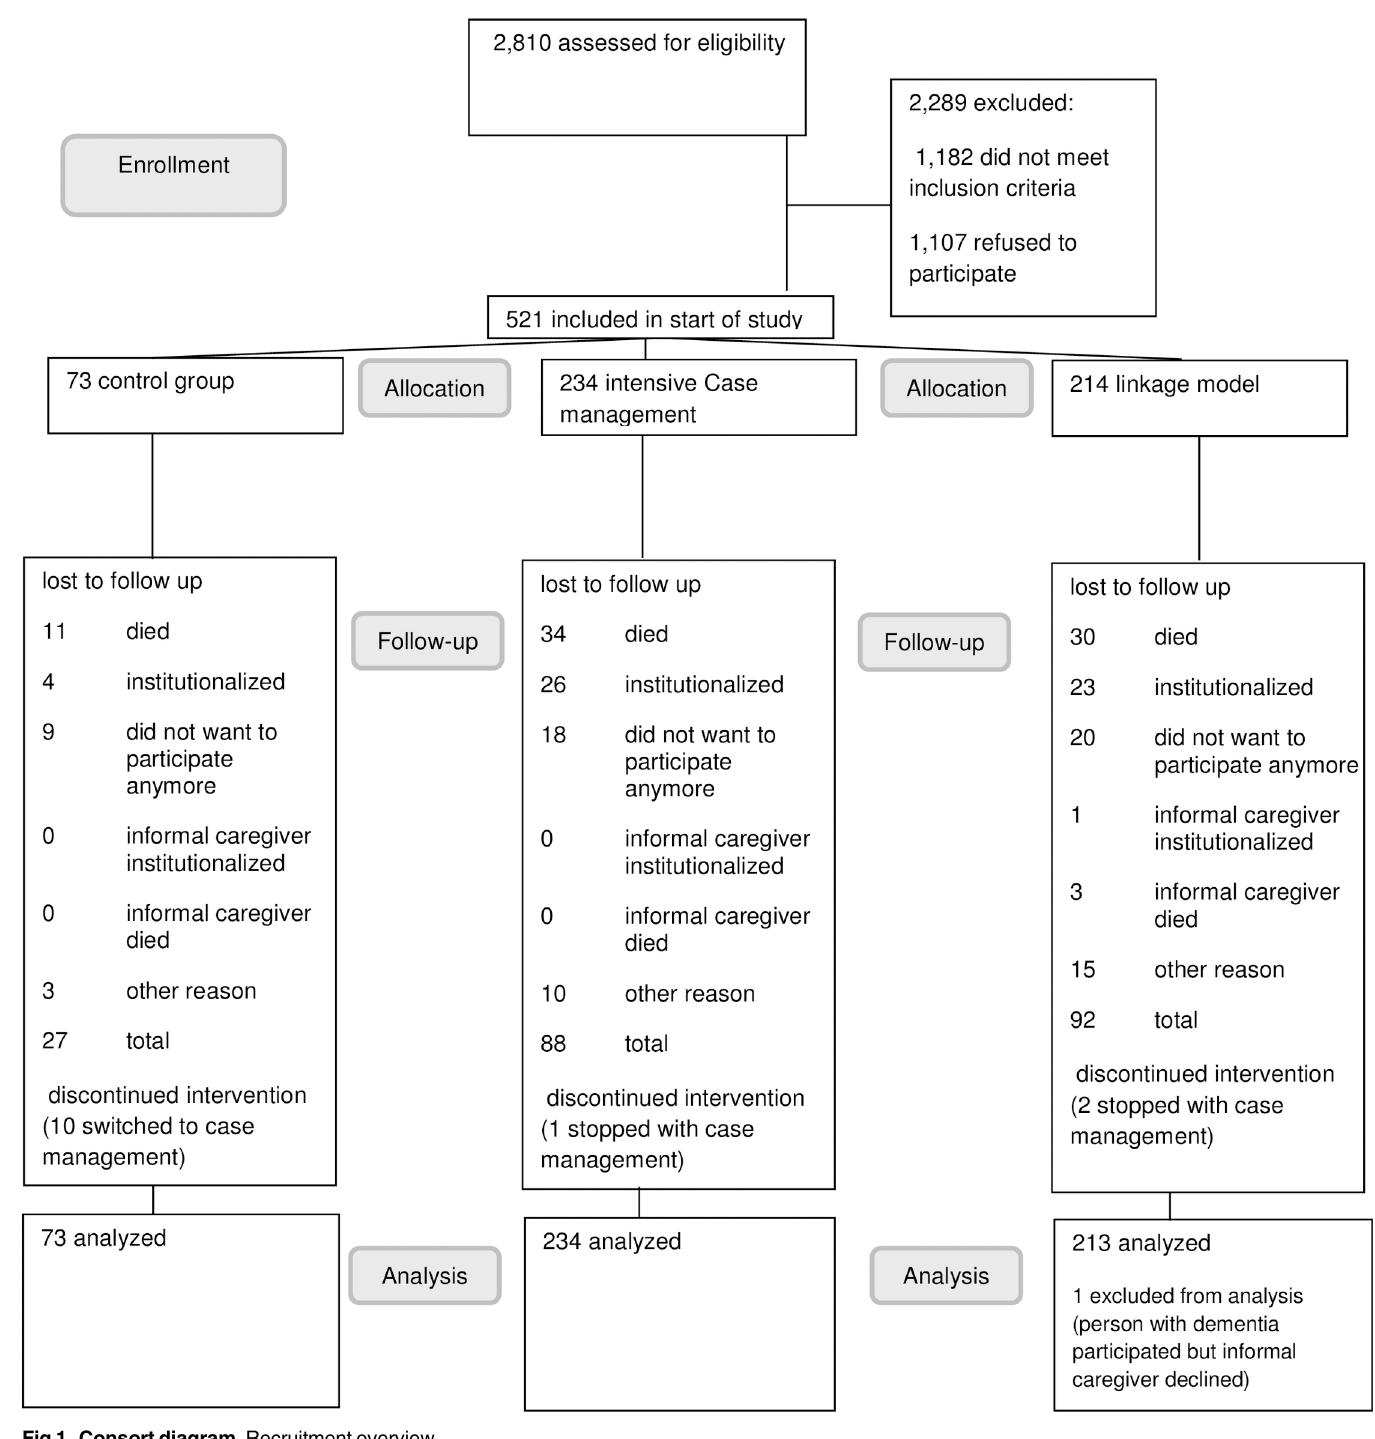
deaths between the three groups (n = 39 deaths for ICMM n = 32 for LM and n = 11 for control group). Persons with dementia who died during the study were more likely to be older (-3.1